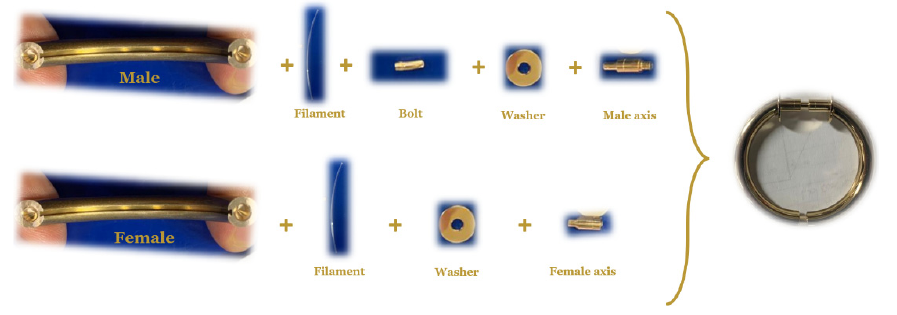
Figure 8. Components required for the final product — “ring”.